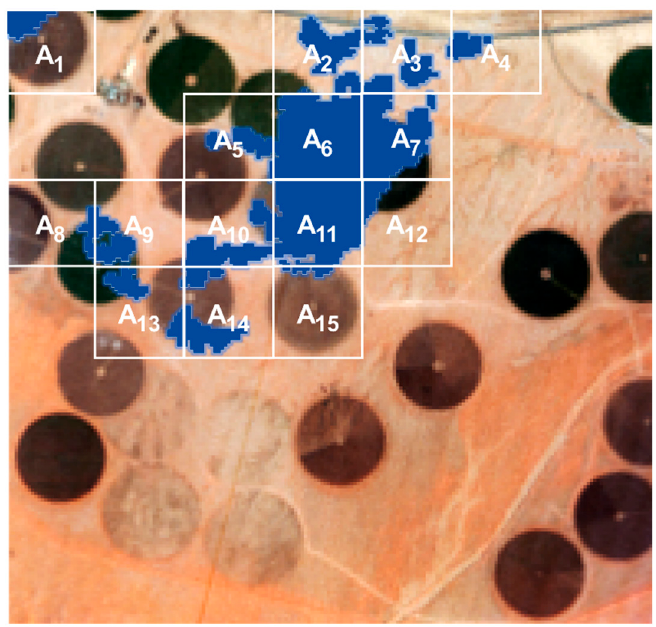
Figure 3. Cloudy areas masked (blue) from the t 8 scene are divided into 15 different regular blocks accounting for different cloud cover percentages.